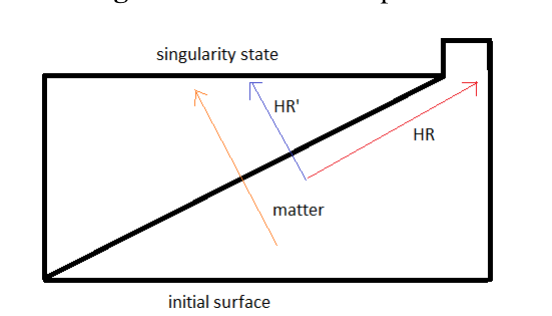
Figure 1. Semiclassical